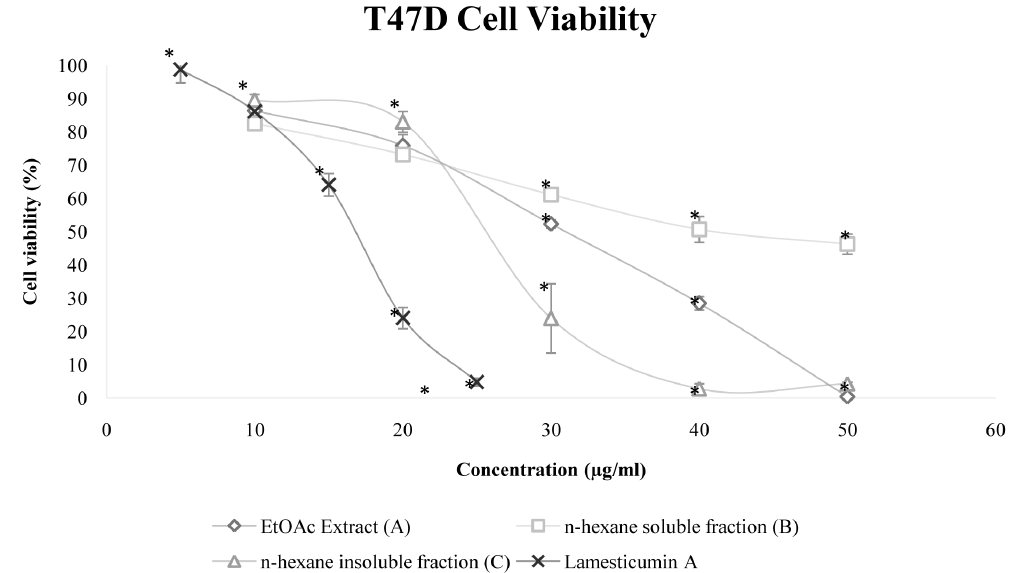
Figure 3. T47D breast cancer cell line viability after treatments with extracts from Lansium domesticum fruit peels. Error bar shows standar deviation (SD, n=3). symbol (*) indicates statistical significance (p<0.05).